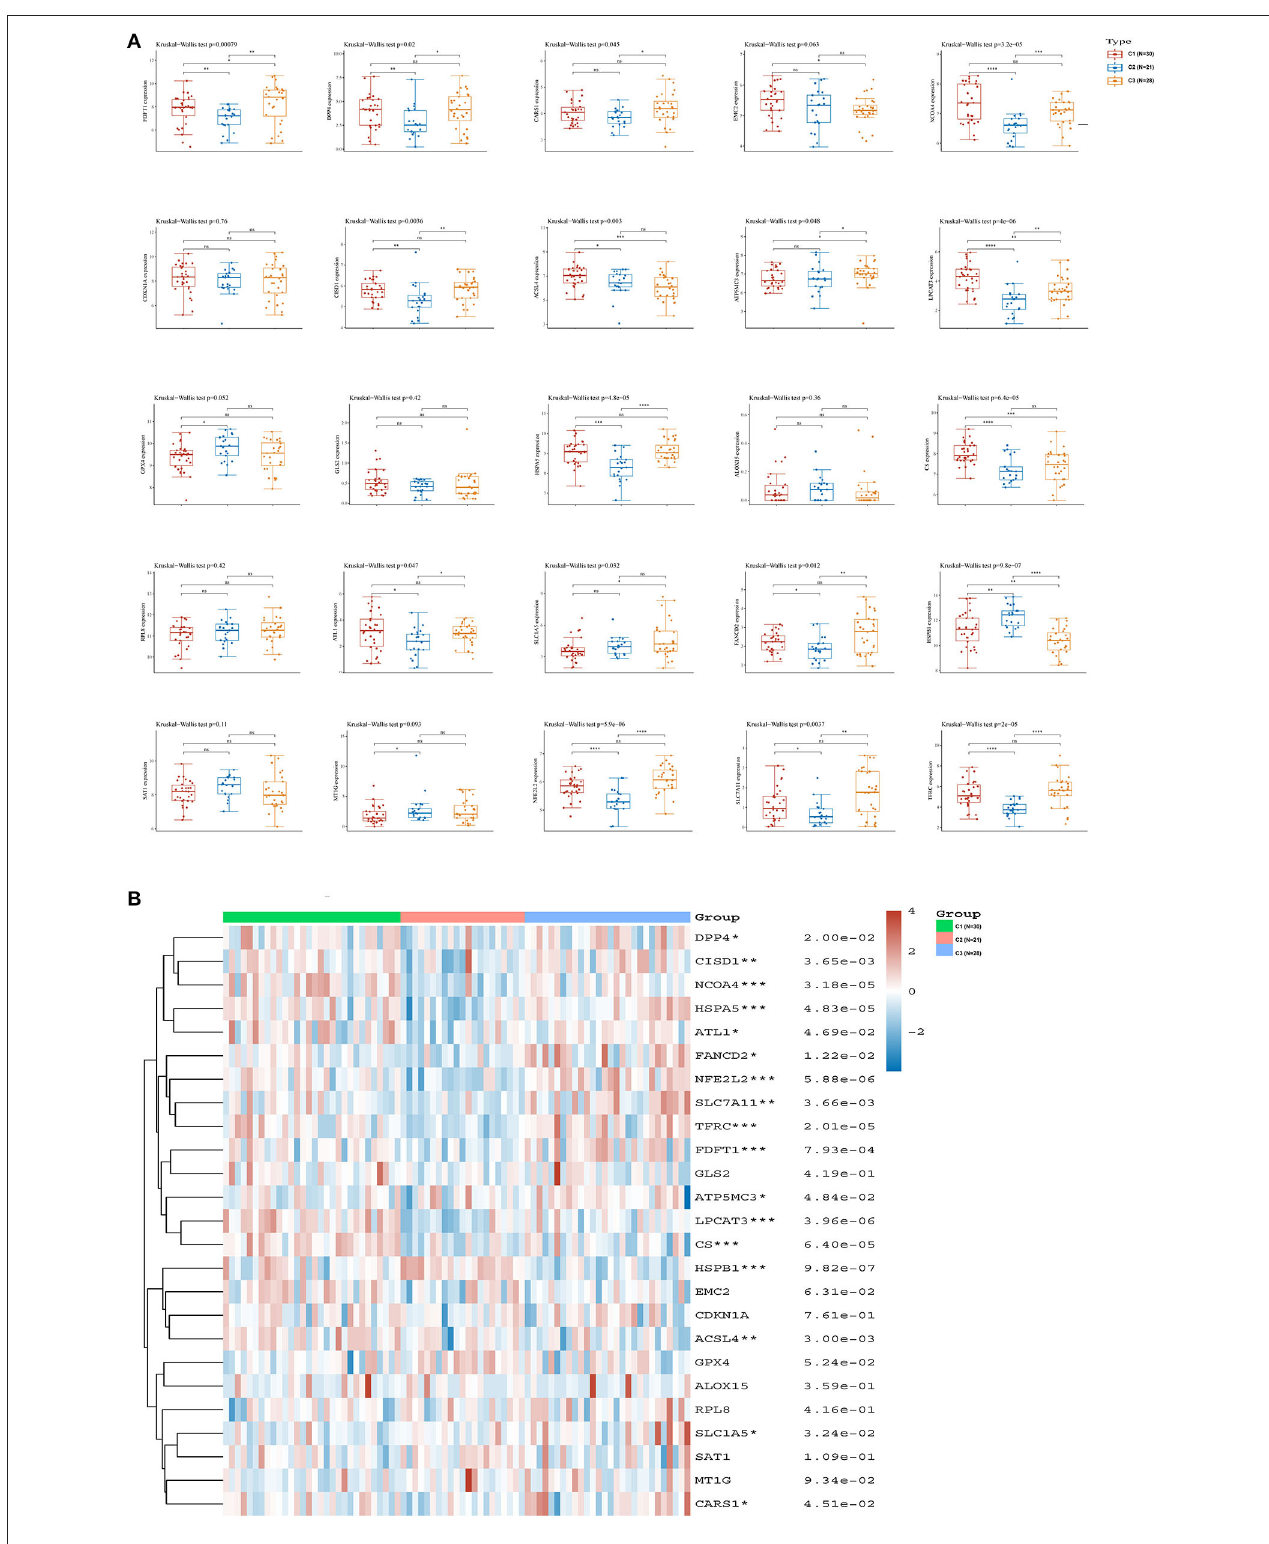
FIGURE 3 | Relationship between hypoxia-related subtypes and ferroptosis in ACC. (A) The expression distribution of ferroptosis-related genes among the three hypoxia-related subtypes; (B) Ferroptosis-related gene expression heatmap. ACC, adrenocortical carcinoma. *: P < 0.05; **: P < 0.01; ***: P < 0.001.